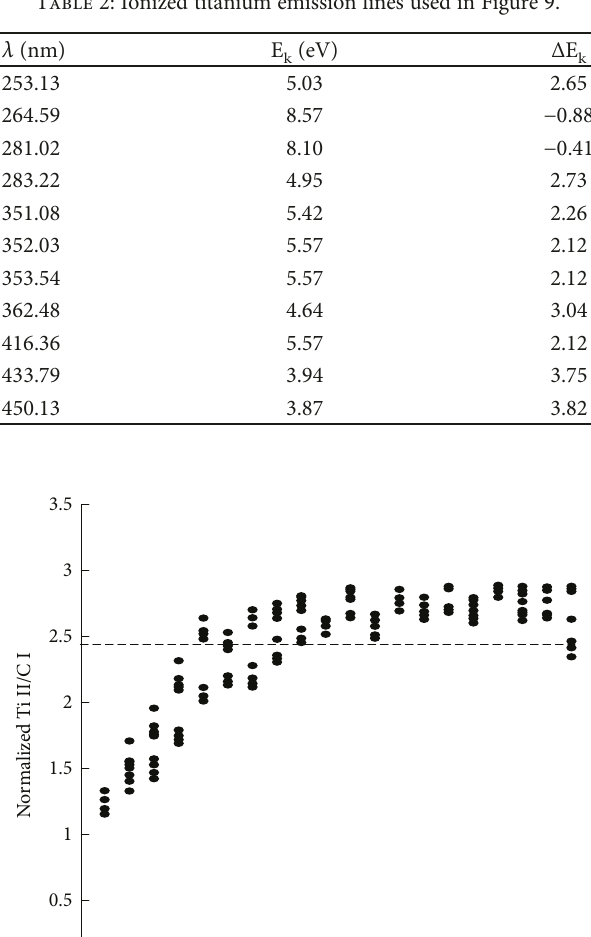
Table 2: Ionized titanium emission lines used in Figure 9.